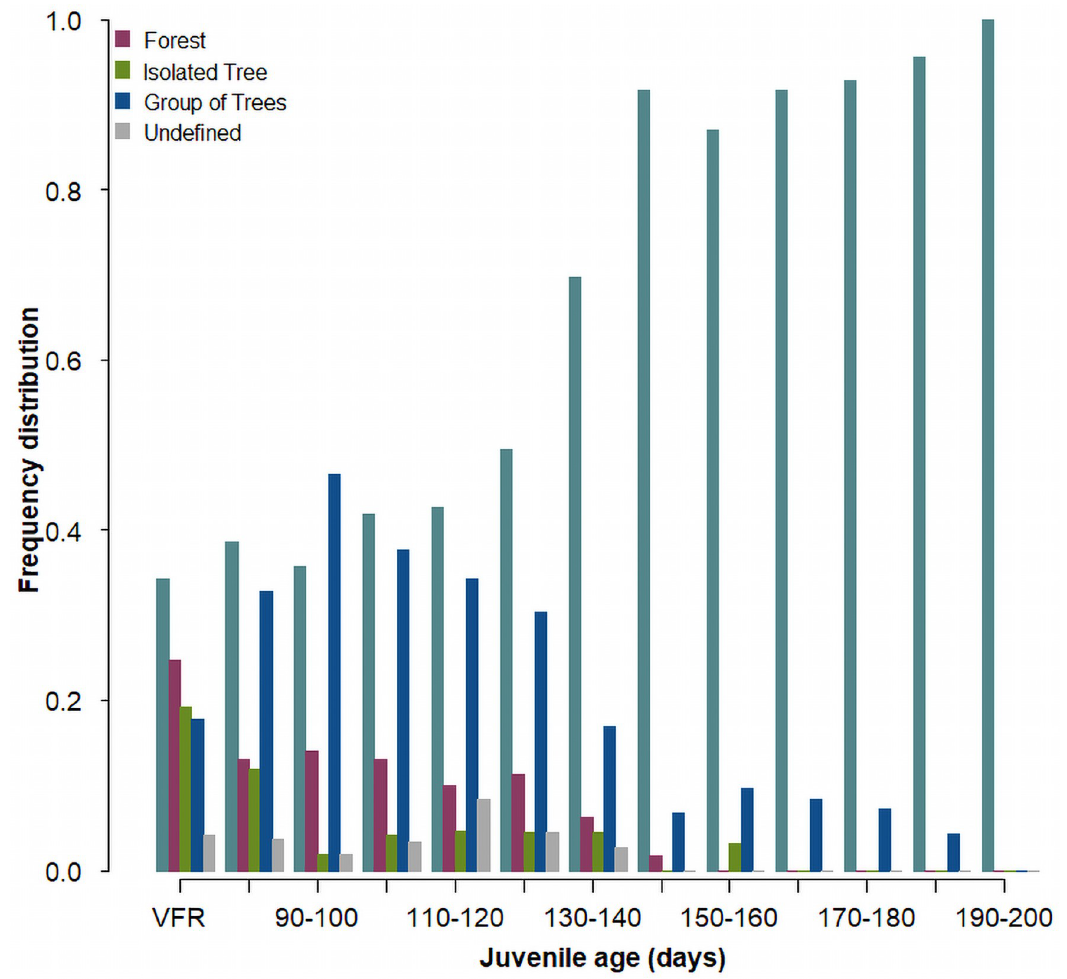
Fig 1. Frequency distribution of diurnal roost sites for 95 juvenile barn owls found for the very first time (VFR) outside their nest box in 79 individuals and between age 80 and 190 days in 70 individuals totalling 1529 observations.